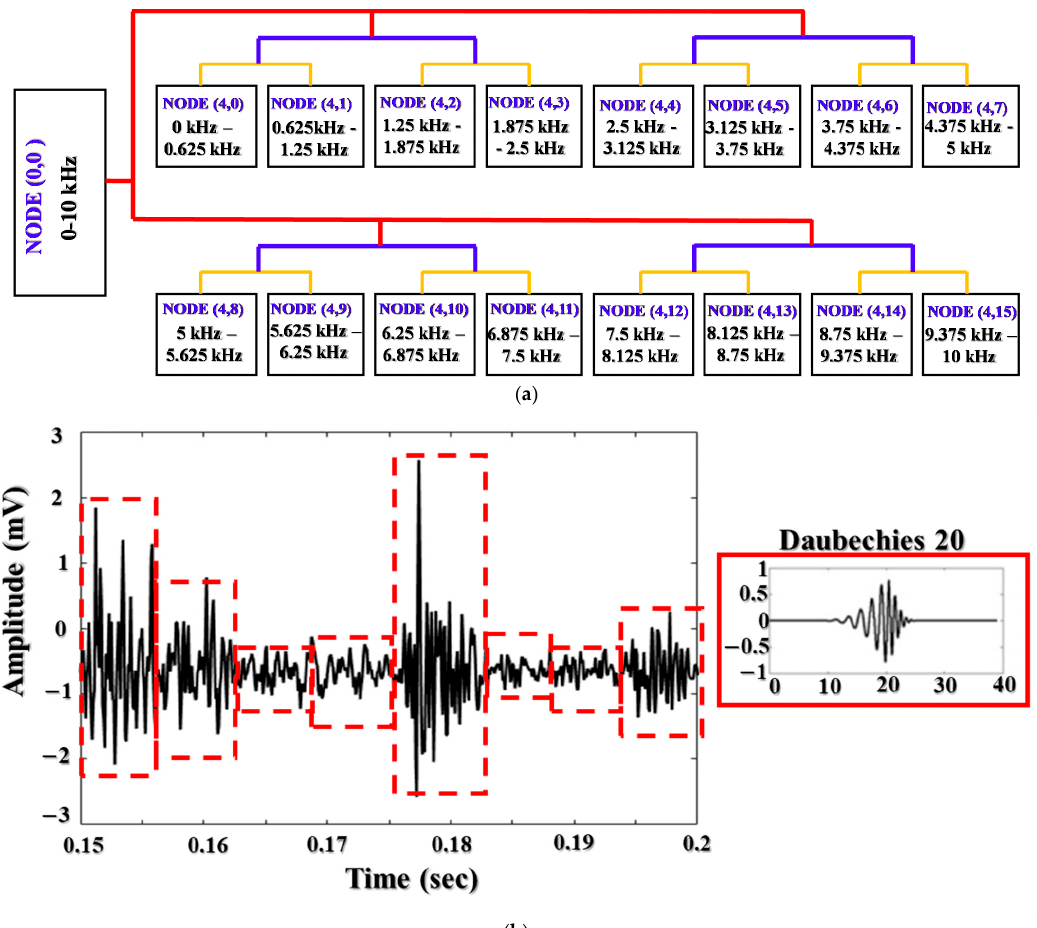
Figure 7. Four-level wavelet package decomposition ( a ) and the analogous oscillation patterns of a vibration signal and the Daubechies 20 function ( b ). vibration signal and the Daubechies 20 function ( b